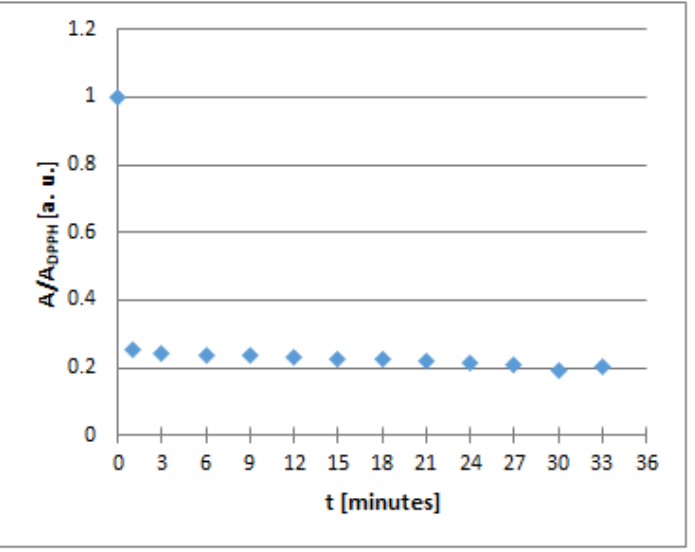
Figure 14. Changes of the relative amplitude (A/A DPPH ) of EPR spectra of DPPH free radicals with increasing time of interactions ( t ) with ascorbic acid. A—amplitude of the EPR line of DPPH free radicals in contact with ascorbic acid. A DPPH —amplitude of the EPR line of DPPH free radicals in the reference solution. For the reference solution, the relative amplitude (A/A DPPH ) take a value of 1.